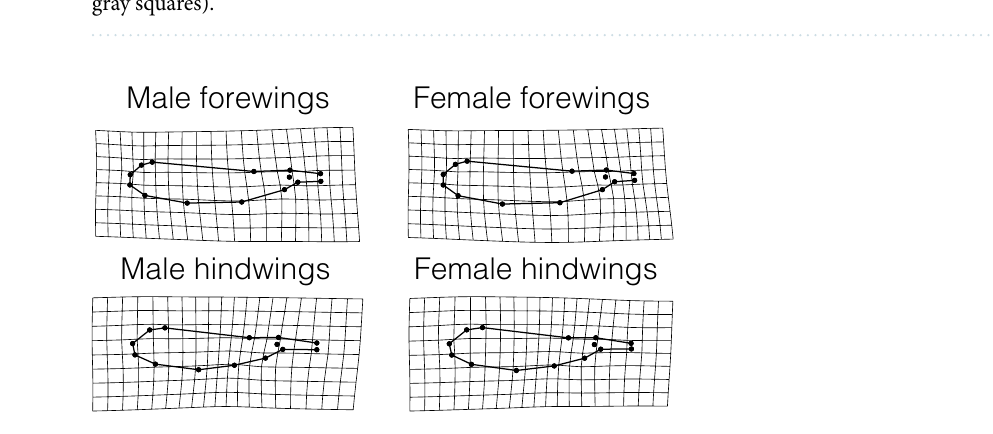
Figure 3. Wing shape variation of Lestes sponsa across all the populations studied. The thin-plate splines grids are exaggerated × 3 times for ease of visualization and show the extremes of variation for each corner of the plot. (female forewings: black circles; female hindwings: black squares; male forewings: gray circles; male hindwings: gray squares).